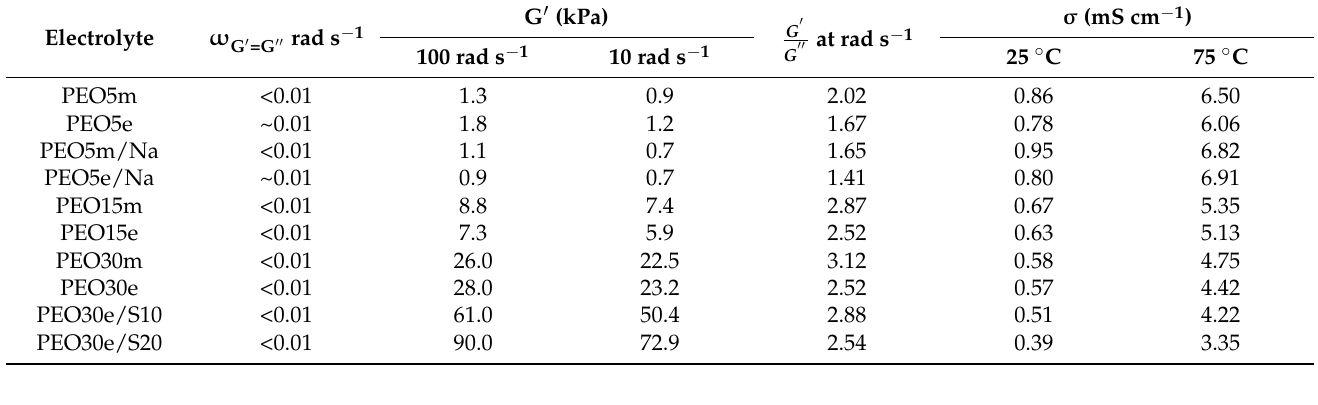
Table 2. Physicochemical characterization of the gels. The crossover ω G (cid:48) =G (cid:48)(cid:48) , the elastic modulus G (cid:48) at 100 and 10 rad s − 1 , calculated at 0.05 rad s − 1 and ionic conductivity ( σ ) at 25 and 75 ◦ C. the ratio G (cid:48) G (cid:48)(cid:48)